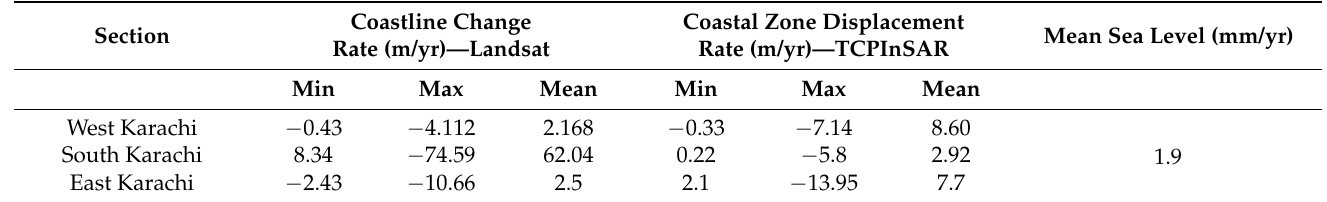
Table 2. Coastal evolution and possible contribution of erosion, ground displacement, and mean sea levels along different section of Karachi’s